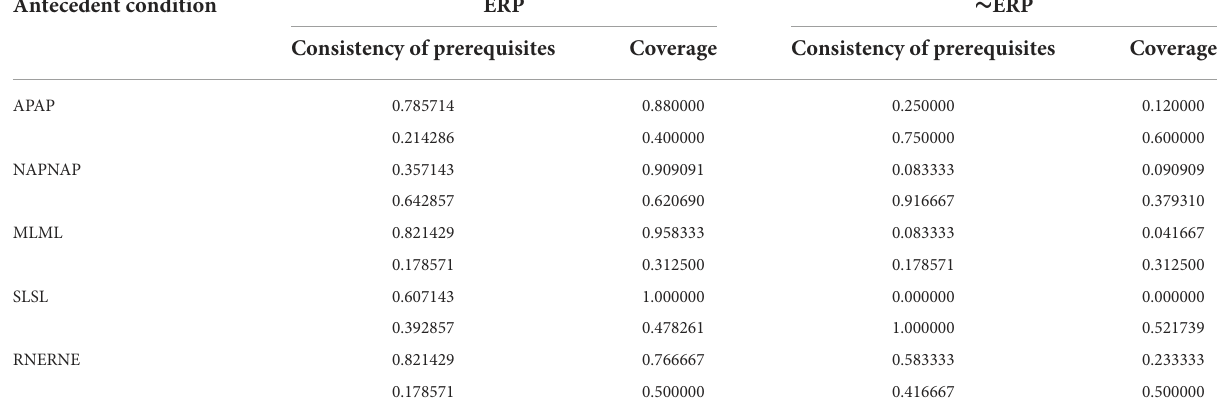
TABLE 4 Univariate necessity analysis test.